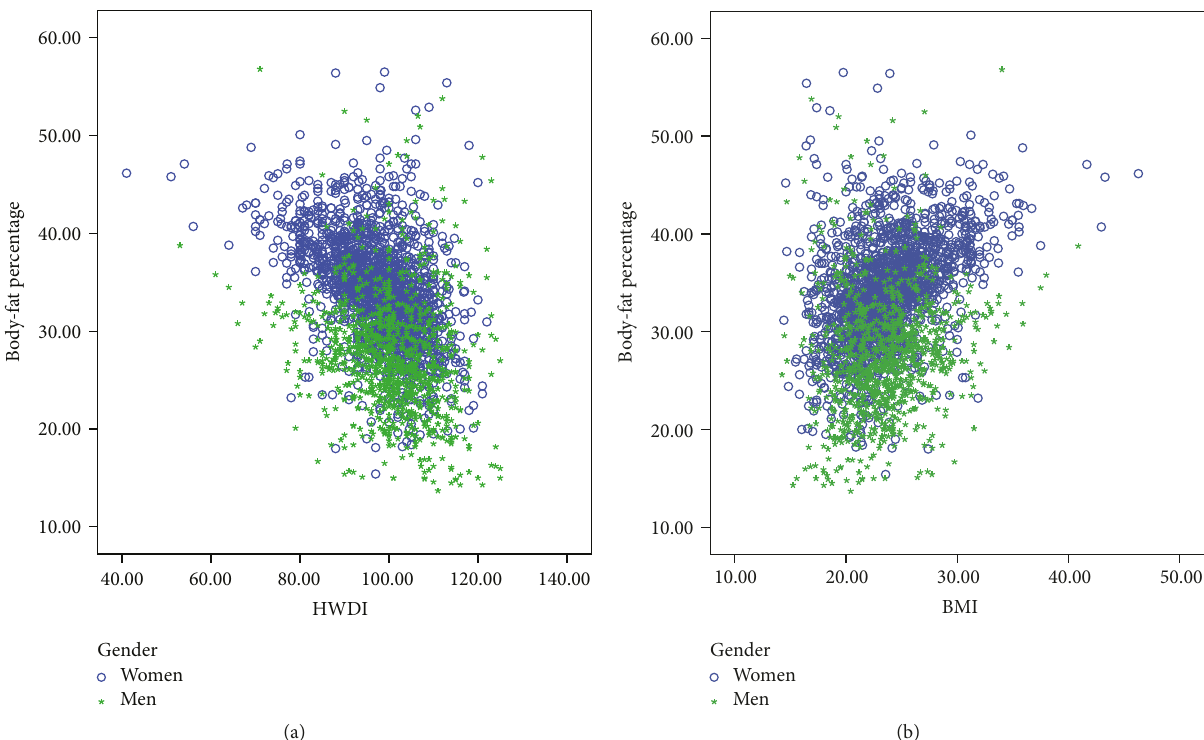
Figure 2: Relationship between (a) HWDI and body-fat percentage and (b) BMI and body-fat percentage, ( I ) for women and (*) for men.